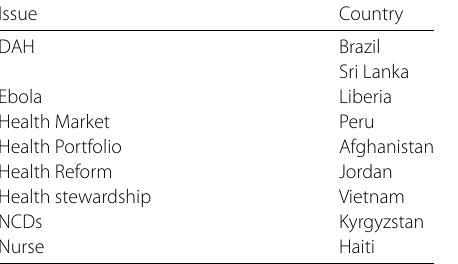
Table 5 The most associated issue per country to WS